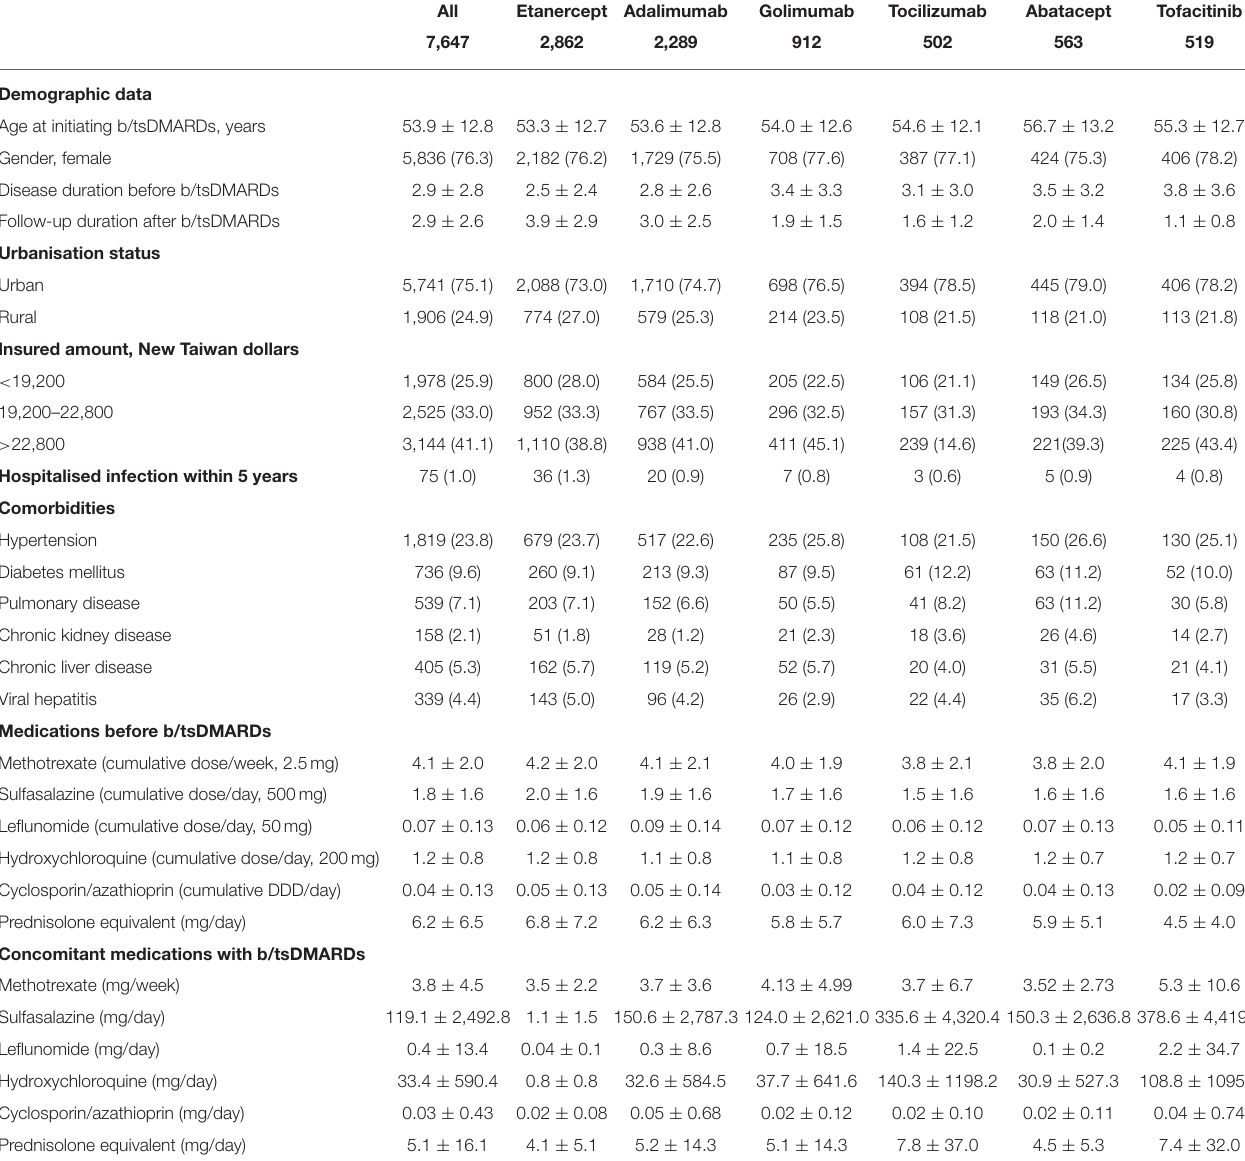
TABLE 1 | Characteristics of enrolled subjects with RA receiving